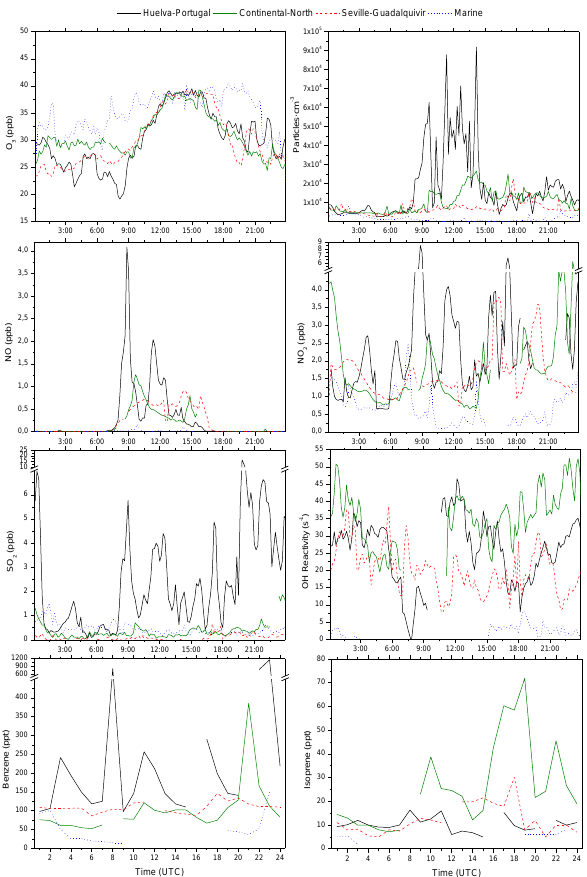
Fig. 7. Mean diel variation for ozone, particles with D >2.5nm, NO, NO 2 , SO 2 , total OH reactivity, benzene and isoprene for air with different